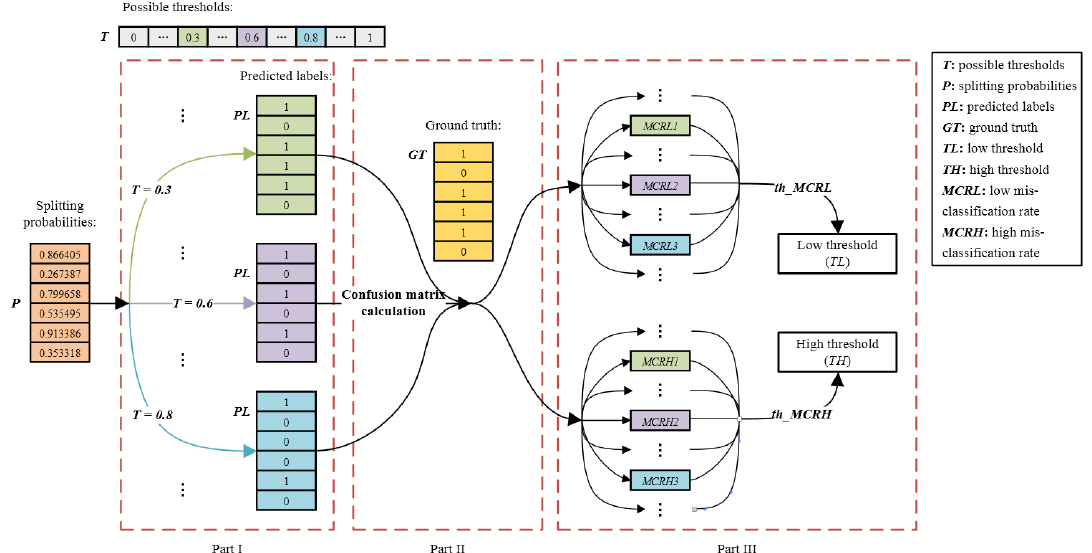
Figure 10. Flowchart of adaptive thresholds calculation method. P is the splitting probabilities of samples, and it is the output of classifier. T is possible thresholds used to generate a predicted CU label. PL represents the predicted labels of samples, and it is transferred from P with T . GT is the ground truth of samples. Part I is the mapping process from the probabilities to the predicted labels. Part II is the confusion matrix calculation process according to PL and GT . Part III illustrates the thresholds determination according to misclassification rates with corresponding thresholds. Blocks in the same color are the results generated under the same value of T